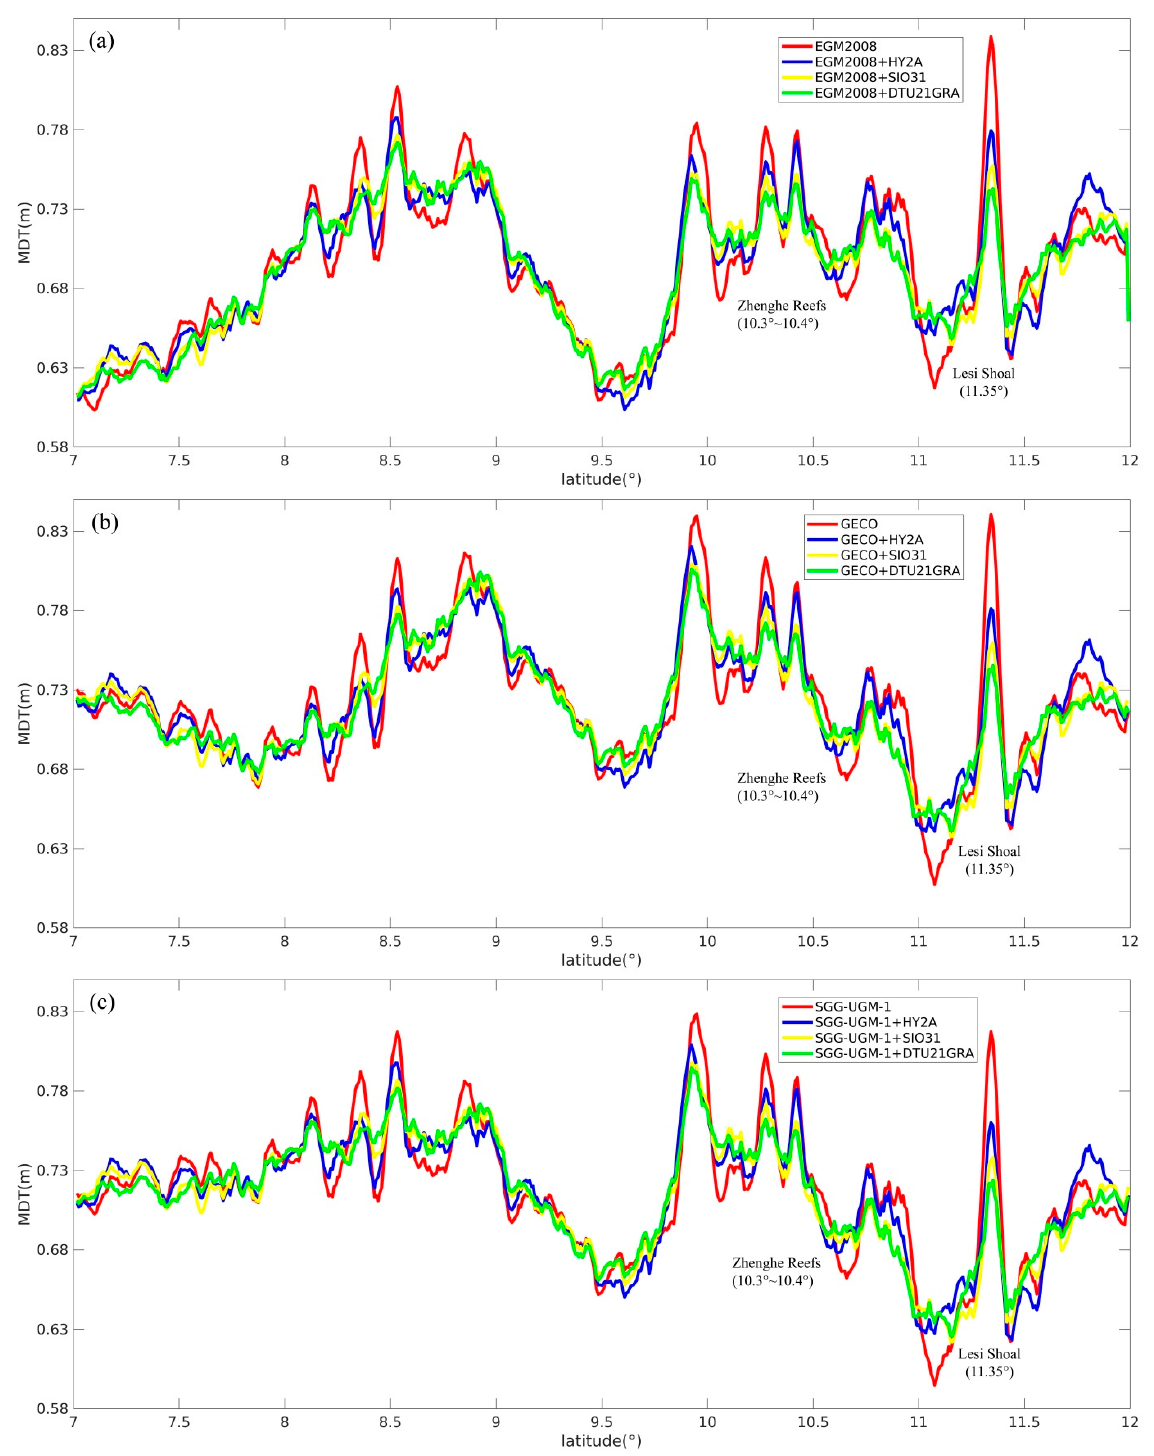
Figure 10. Profiles of the MDTs modeled with ( a ) EGM2008, ( b ) GECO, and ( c ) SGG-UGM-1 based on different altimetric gravity models along longitude 114.6°N. on different altimetric gravity models along longitude 114.6 ◦